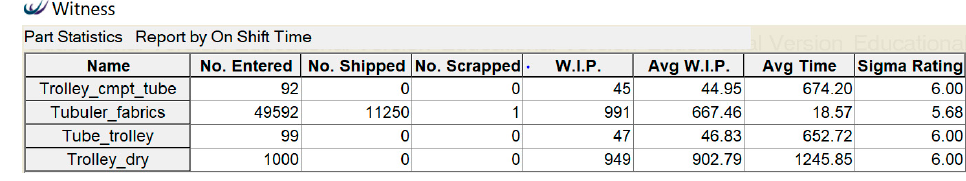
Figure 9. Tubular production line optimization data. Table 4. Modification list of the tubular production